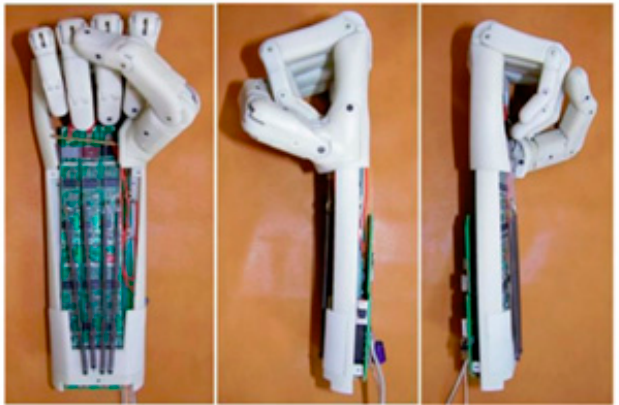
Figure 4. The SMA prosthetic hand took advantage of pre-tension spring and feedback control to have a better performance [21].